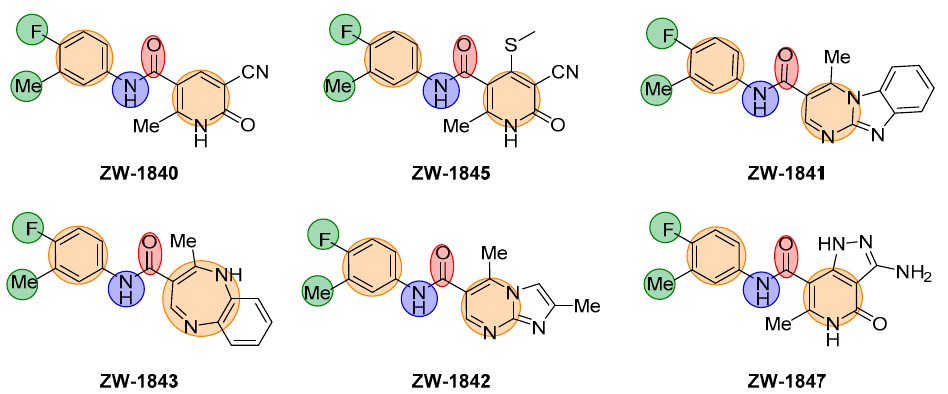
Figure 5. Designed and in-house synthesized compounds based on the pharmacophore model.